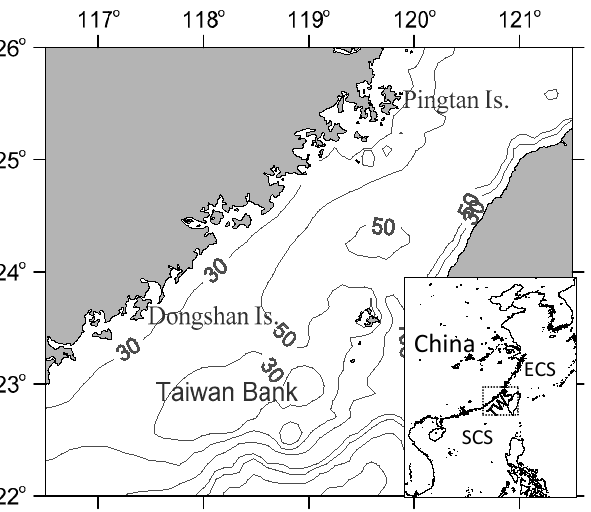
Figure 1. Map of the study area, overlaid with the bathymetry contours in meters. TWS: Taiwan Strait; ECS: East China Sea; SCS: South China Sea; Is.: Island.